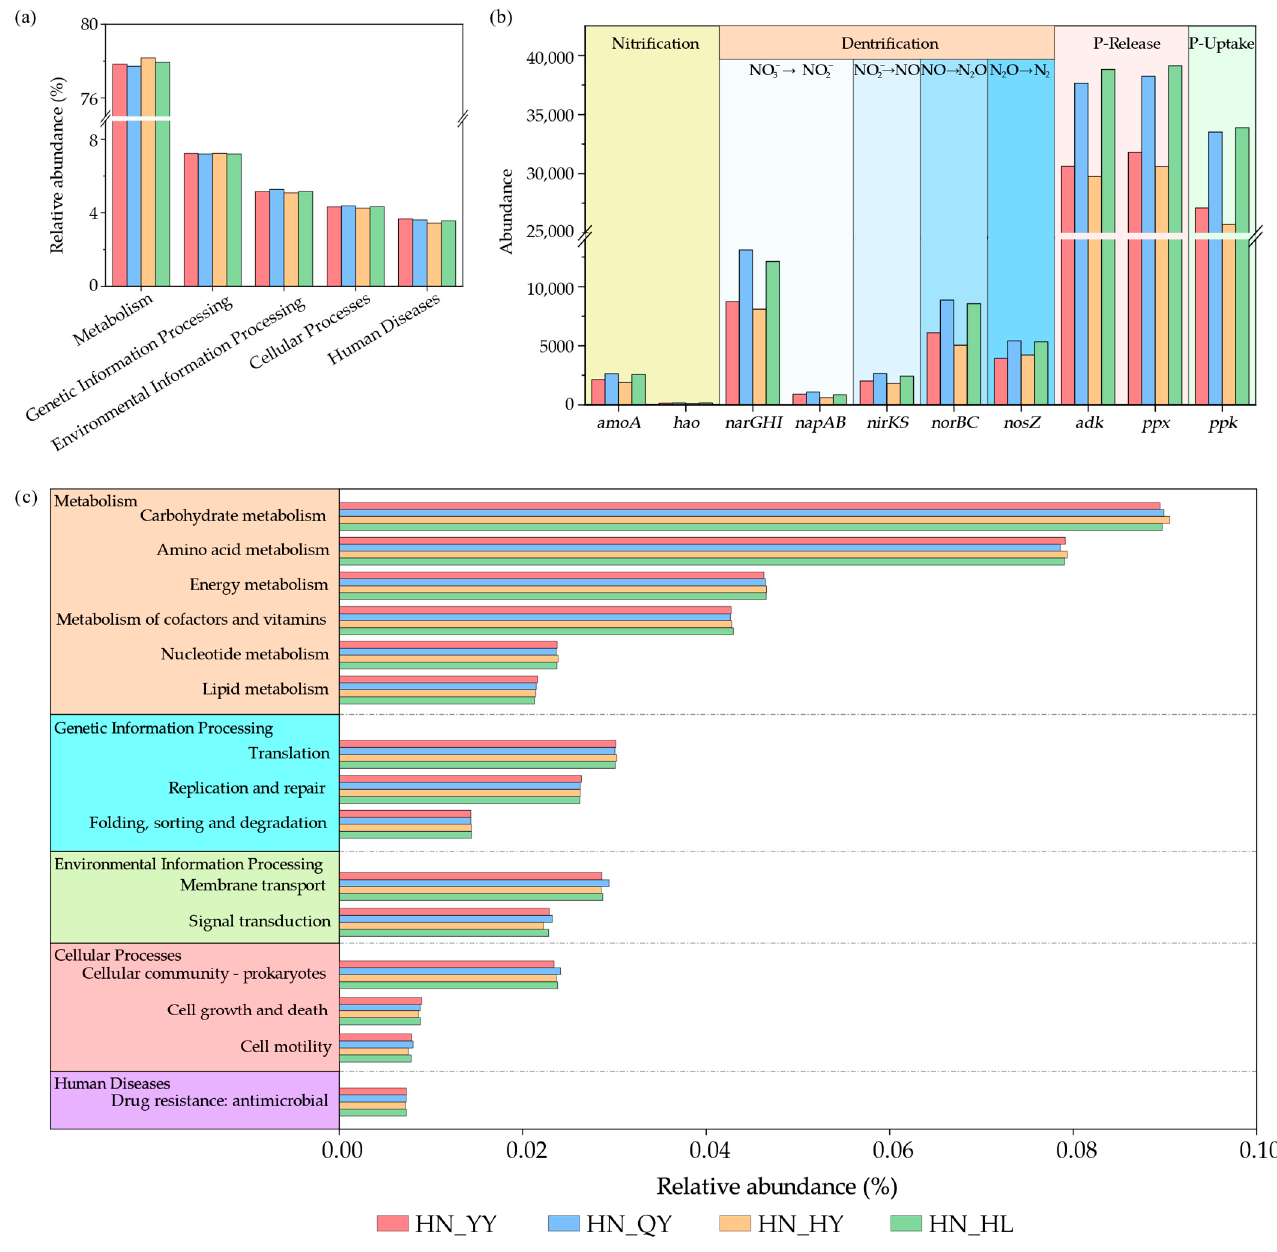
Figure 4. Bacterial function pathways according to KEGG in the anaerobic sludge (HN_YY), anoxic sludge (HN_QY), aerobic sludge (HN_HY), and return sludge (HN_HL) of Haikou WWTPs. ( a ) Function pathways at level 1; ( b ) frequencies of the key genes including nitrogen and phosphorus removal according to the KO numbers assigned to genes; and ( c ) function pathways at level 2.